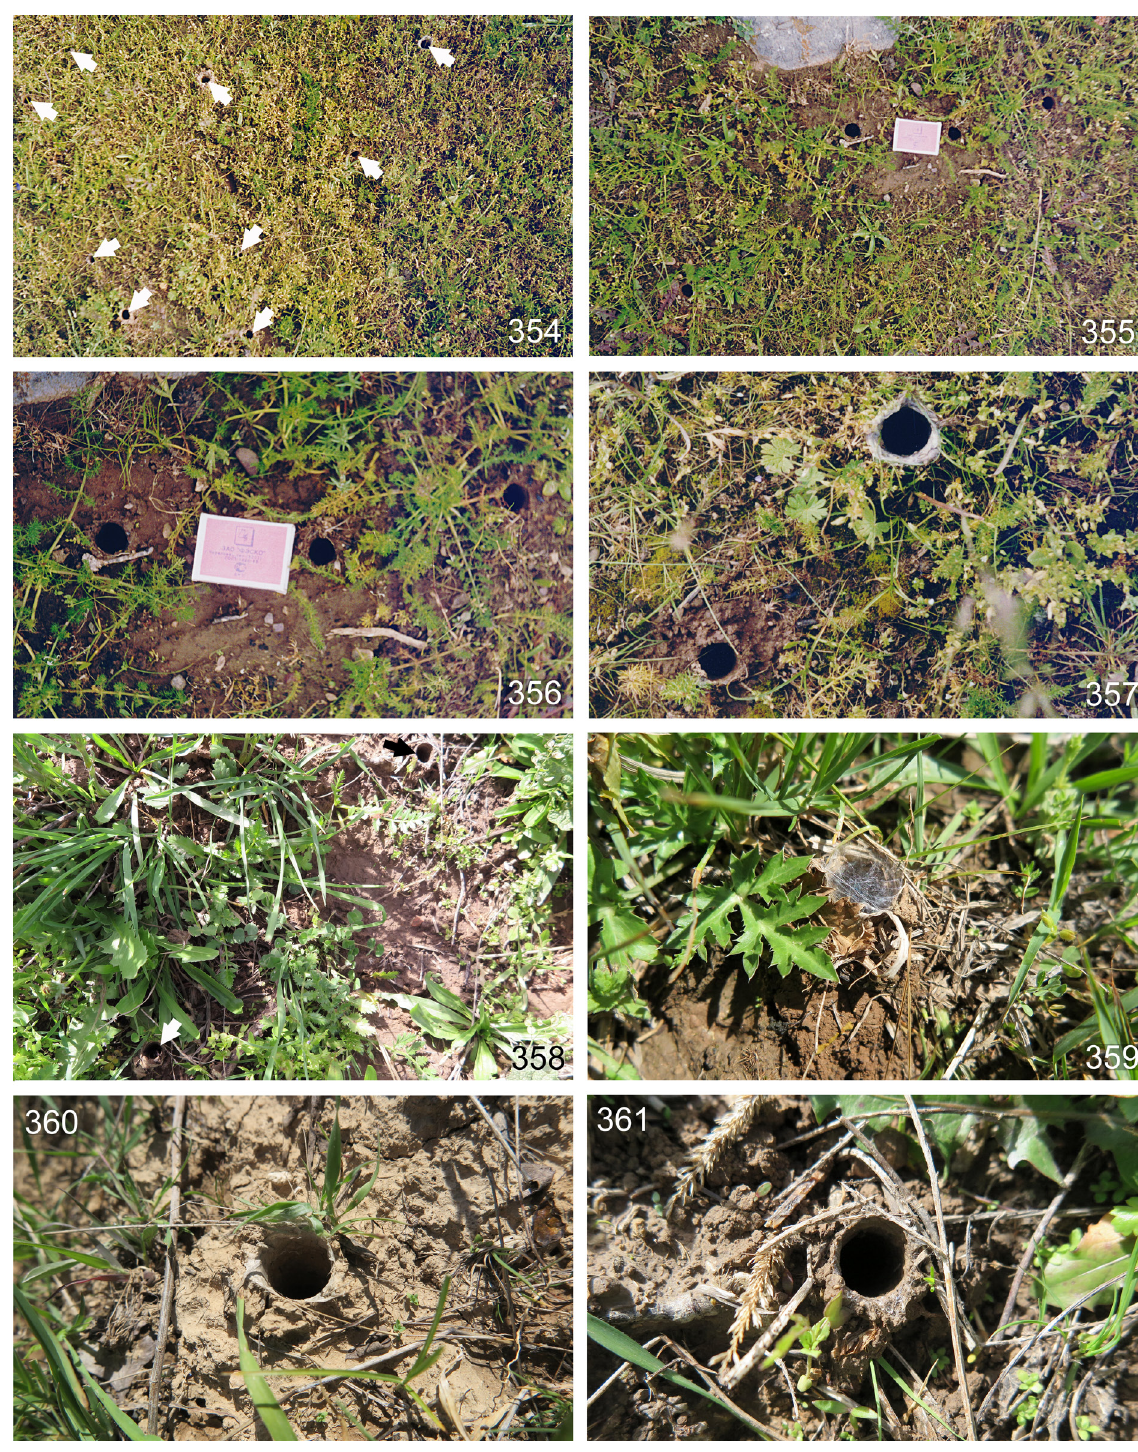
Figs 354–361. Anemesia spp., burrow entrances of A. infuscata sp. nov. (354–356, 358–361 and 357, bottom left) and A. oxiana sp. nov. (357, above centre): opened (354–358, 360–361), aggregated (354– 358) and curtained with web (359); located on the open ground (354–357) and on the forest floor (358– 361); Tajikistan. 354–357 . Sangdara. 358 – 361 . Sultanmazar. White and black arrows indicate burrow entrances. A matchbox 5 cm long intended to capture a live spider is used to indicate